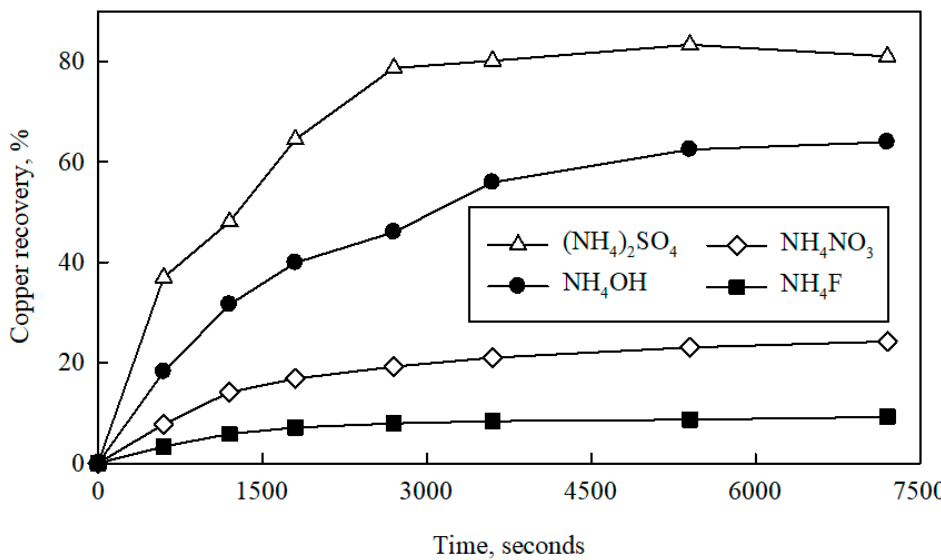
Figure 11. Evaluation of the influence of different ammonium reagents on the malachite leaching Working conditions: NH 4 OH = 0.1 mol / dm 3 , temperature = 298 K, particle size = 5 µ m, pH = 10.5, rate. Working conditions: NH 4 OH = 0.1 mol/dm 3 , temperature = 298 K, particle size = 5 μ m, pH = 10.5, stirring rate = 500 rpm and S / L ratio = stirring rate = 500 rpm and S/L ratio = 1:1000.